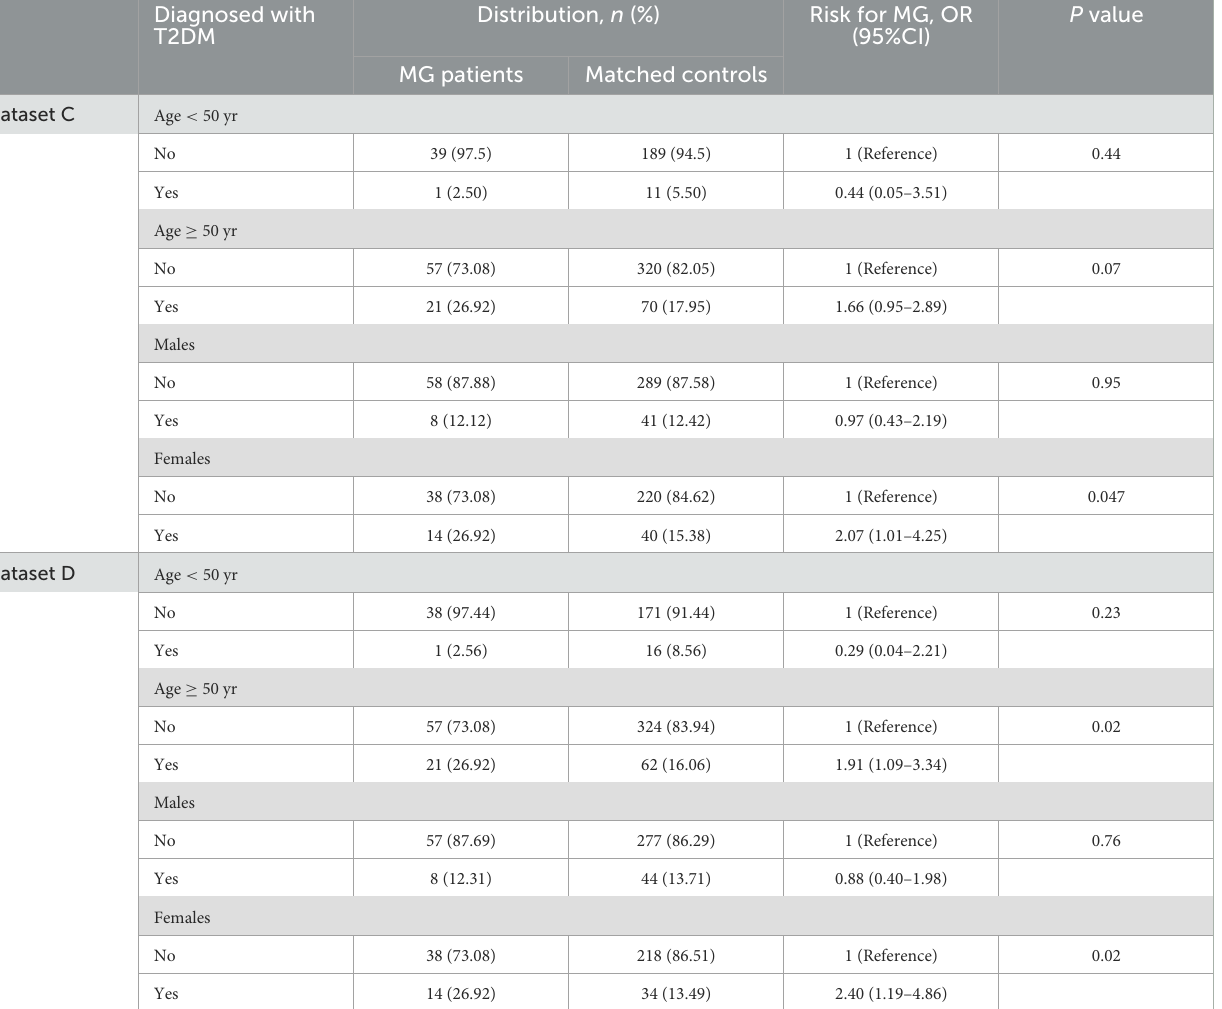
TABLE 3 Distribution of T2DM and associated risk for MG in datasets C and D. Diagnosed with